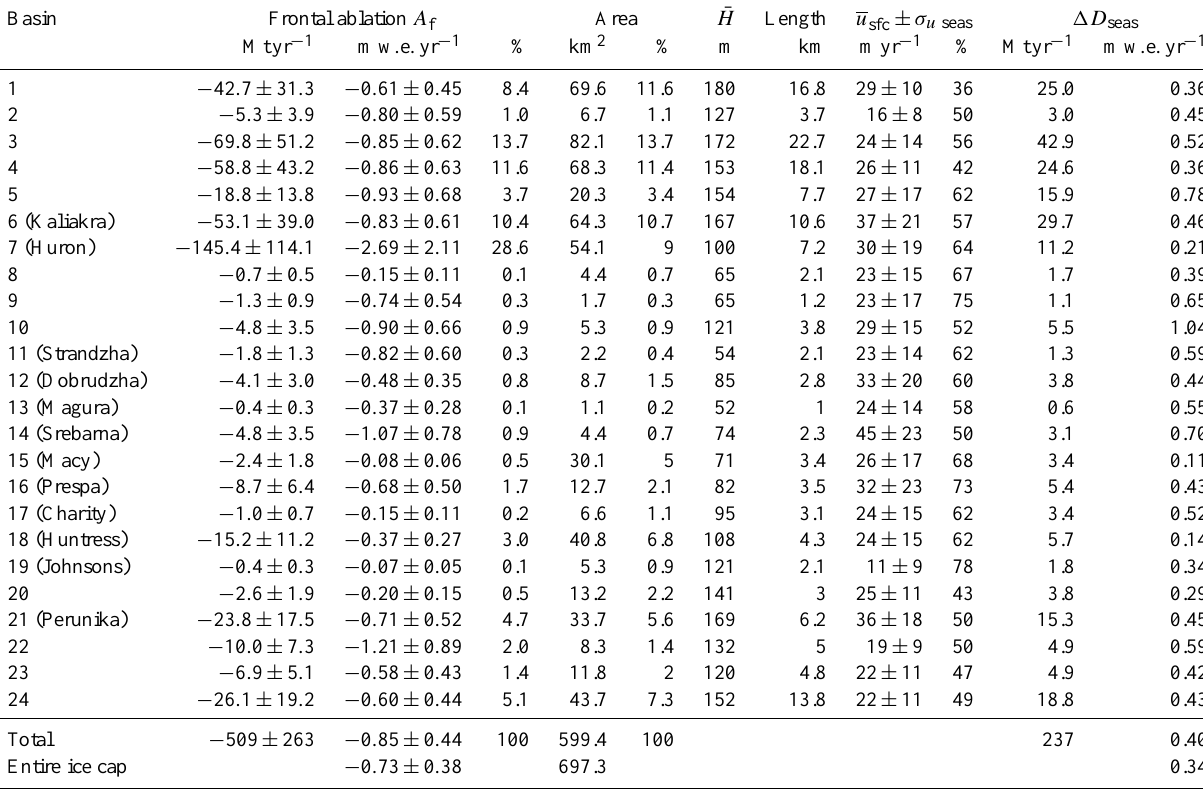
Table 2. Estimated frontal ablation rates A f for the period between October 2007 and March 2011 (including the percentage of the ice cap’s total frontal ablation), basin area (and its percentage of total area), and average thickness ¯ H , length and average surface velocities u sfc of the flux gates of all investigated tidewater glaciers on Livingston Island (Fig. 2). σ u seas is the standard deviation of the available velocities averaged over the flux gates and 1D seas is the associated variation in frontal ablation. Frontal ablation rates are given in Mtyr − 1 and in specific units (mw . e . yr − 1 ). The temporal variations in velocity σ u seas are also expressed as a percentage of each flux gate’s average velocity u sfc